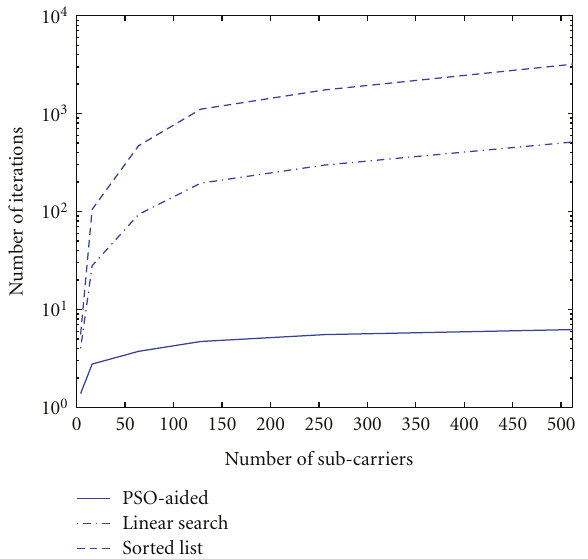
Figure 9: Complexity comparison of linear search, sorted list, and PSO-aided subcarrier allocation algorithms.